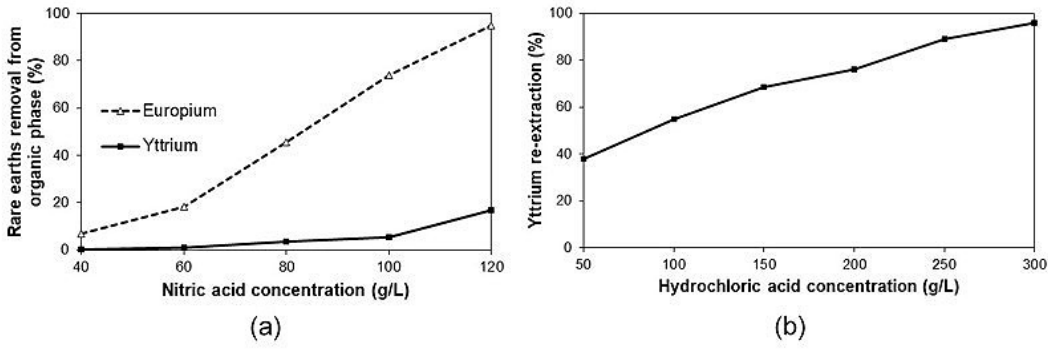
Figure 4. ( a ) Removal of europium with HNO 3 ; ( b ) Re-extraction of yttrium with HCl. When increasing the concentration of HNO 3 , the removal of europium increases. At